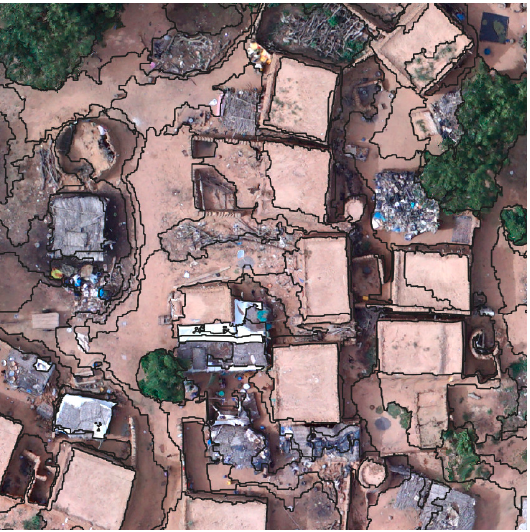
Figure 11. Example of land cover spectral variability within households’ yards.